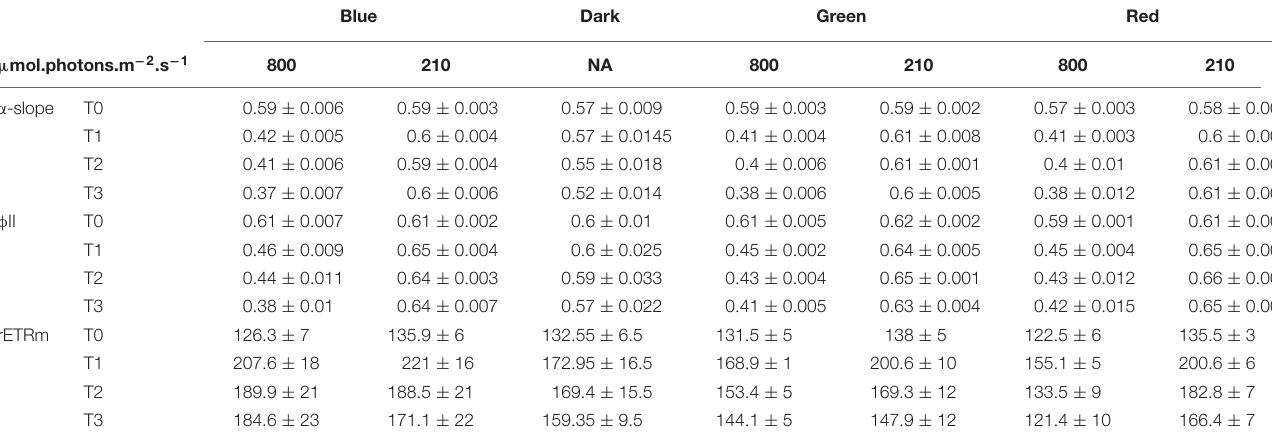
TABLE 2 | Photosynthetic parameters and φ II 1 values obtained from rapid light curve fitting of φ II (E) within the migrationnal biofilm. Blue Dark